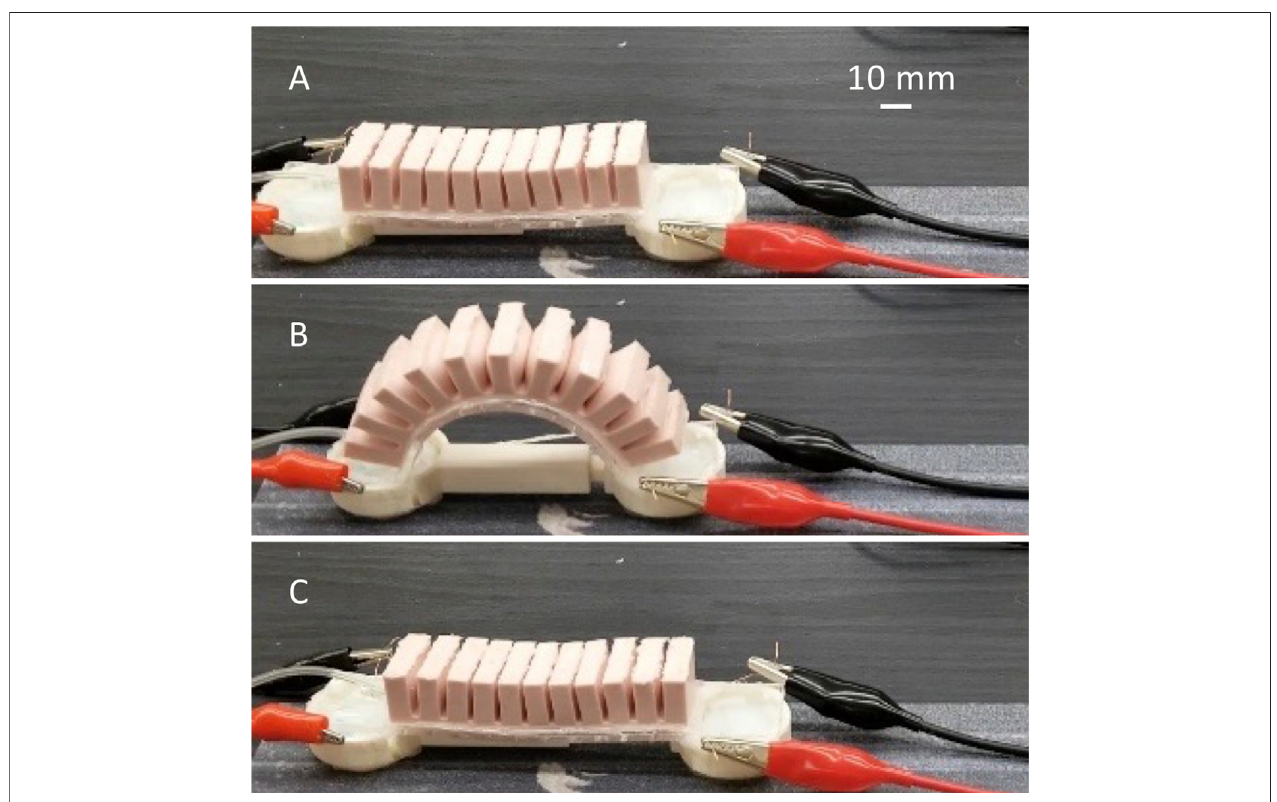
FIGURE 10 | Illustration of the inchworm inspired soft robot crawling forward. (A) Activating the front pad. (B) By pressurizing the soft body, the rear pad moves forward. (C) Deactivating the front pad and activating the rear pad followed by releasing the air from the robot, the front pad moves forward.